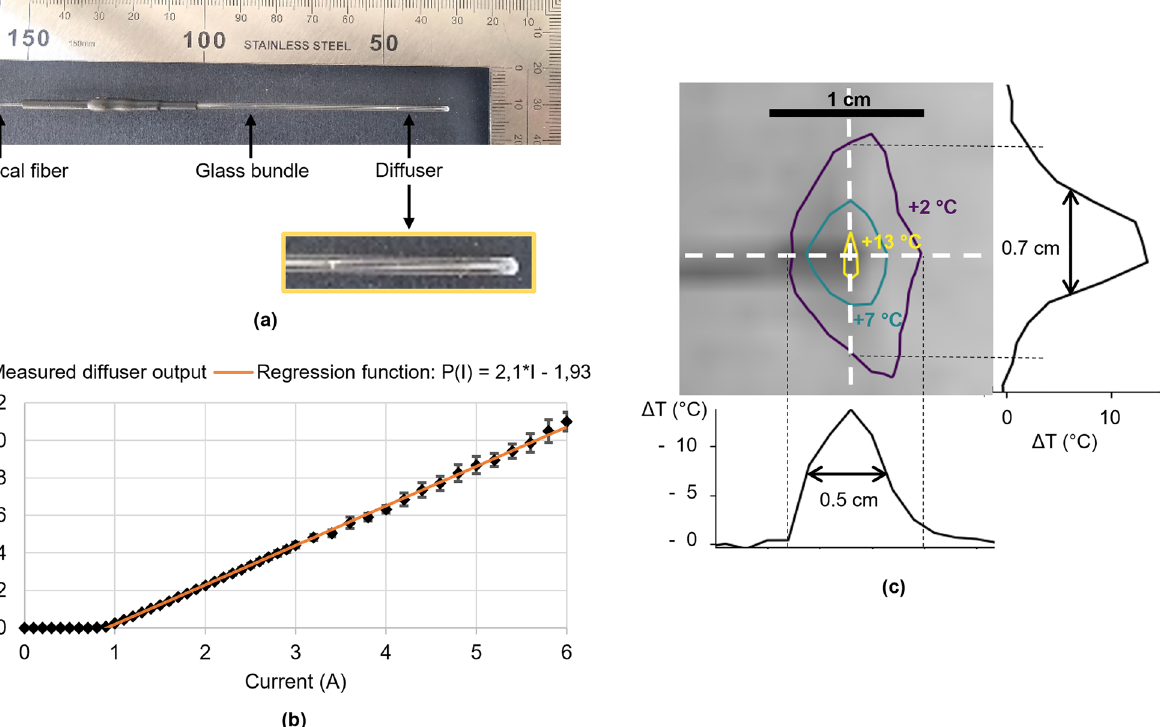
Figure 1. Laser device presentation. A laser probe photograph, with zoom-in on diffuser tip ( a ), its transfer function (Current (A) vs Power (W)) ( b ), and a spatial characterization of the energy deposit ( c